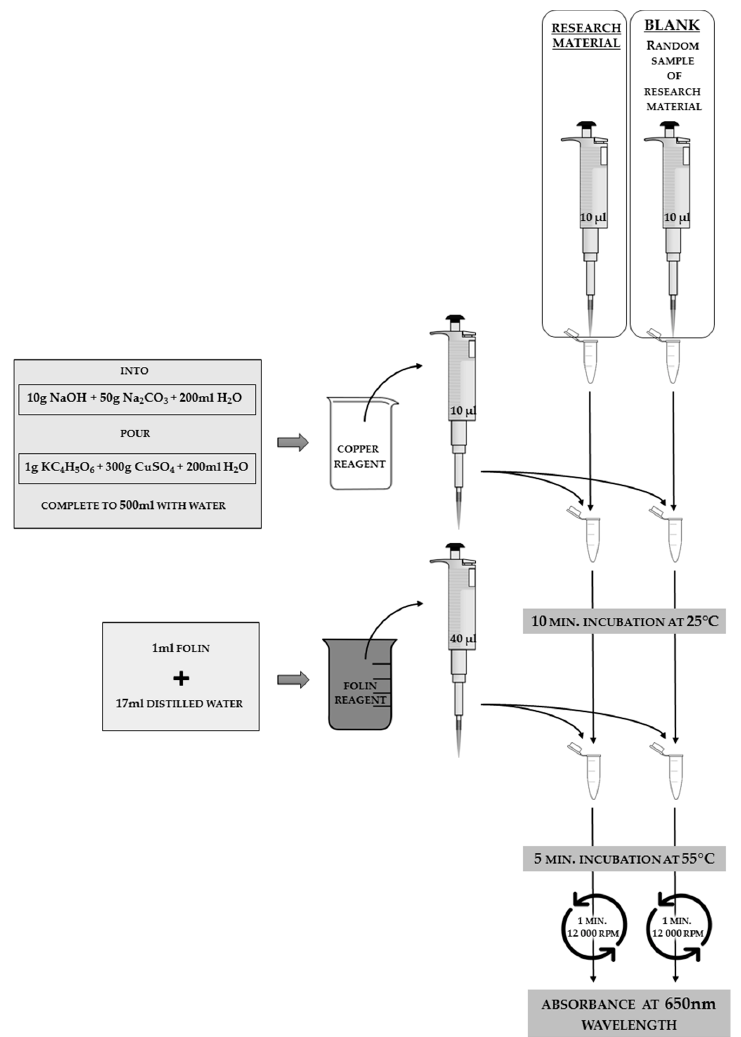
Figure 6. Methodology for analyzing the total protein concentration in the hemolymph solution or in the insect body surface elution. The applied tools and reagents, along with the used volumes, are presented in the scheme. On the left side of the scheme, the exact composition of the copper reagent is presented, as well as the dilution method of the commercially purchased Folin reagent (e.g., Sigma-Aldrich, Folin and Ciocalteu’s phenol reagent), which should be kept in a beaker unexposed to light.